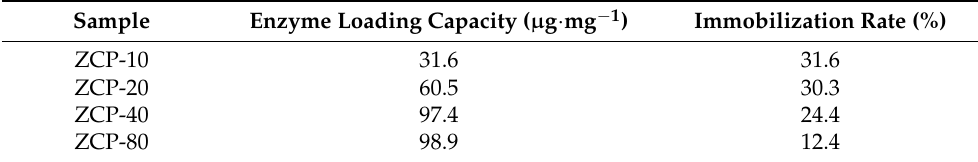
Table 1. Enzyme Loading Capacity and Immobilization Efficiency of CALB-Loaded ZIF-8.